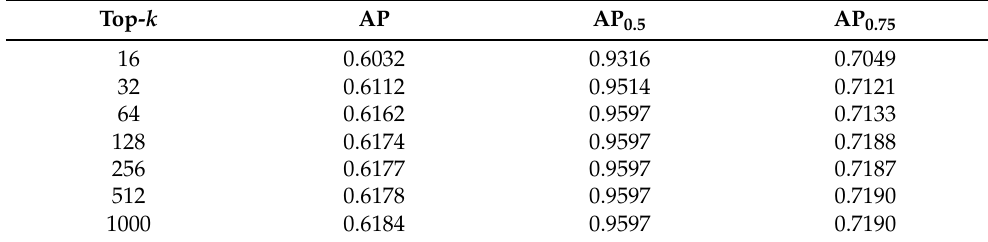
Figure 13. Visualization of proposals generated by the conventional RPN and our AFD. ( a ) proposals from the RPN-based detector, for clarity, we only show proposals with its confidence score > 0.4. ( b ) proposals from the AFD-based detector. Table 8. Analysis of different values of top- k in the first